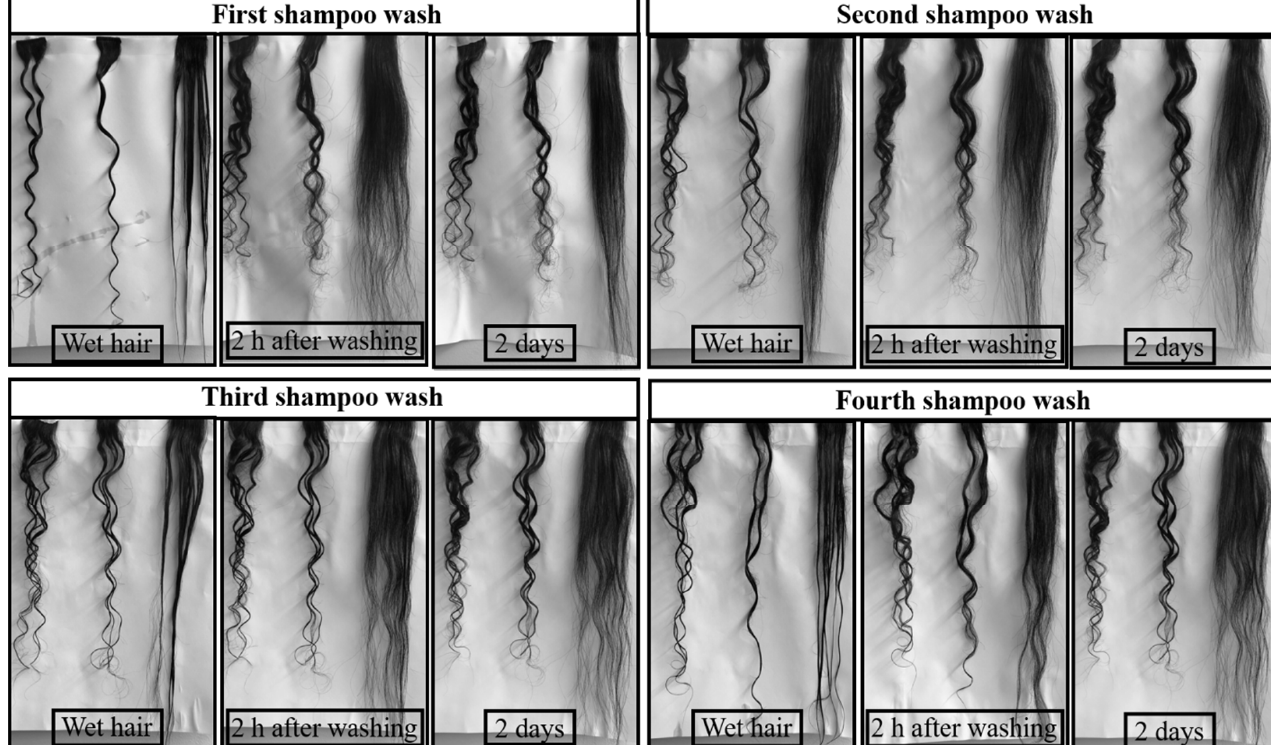
Figure 3. C, FI, and STA hair swatches from left to right in each picture after 4 shampoo washes. The straightening efficiency (SE) values were calculated for FI and STA hair swatches for up to 45 days of exposure to 65% RH and for 21 °C, as well as FI and STA hair swatches after up to 4 shampoo washes, using Equation (1). Figure 4a shows the SE of FI and STA hair as a function of the days the hair swatches were hung on a wall in the conditioning room at 65% RH for up to 45 days. As seen in Figure 4a, the SE of FI and STA hair was 100% on day 0. After 1 day in the conditioning room, the SE of the FI hair reduced to 67%, while the SE of STA hair was still 100%. The change in SE was a result of at least one curl observed in the FI hair after 1 day at 65% RH, while the STA hair was fully straight (SE 100%). This can be clearly seen in Figure 2. The SE of FI hair further reduced to 60% after 2 days in the conditioning room at 65% RH as two additional curls developed on the FI swatch, while a slight curl in the bottom part of the STA hair was observed, bringing down the SE of the STA hair to 87%. The reduction in SE for FI hair to 65% was found to be statistically significant using an unpaired t-test at a significance level of 0.05. The